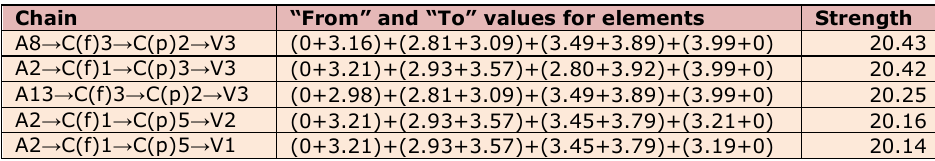
Table 5. Top five chains with the highest strength